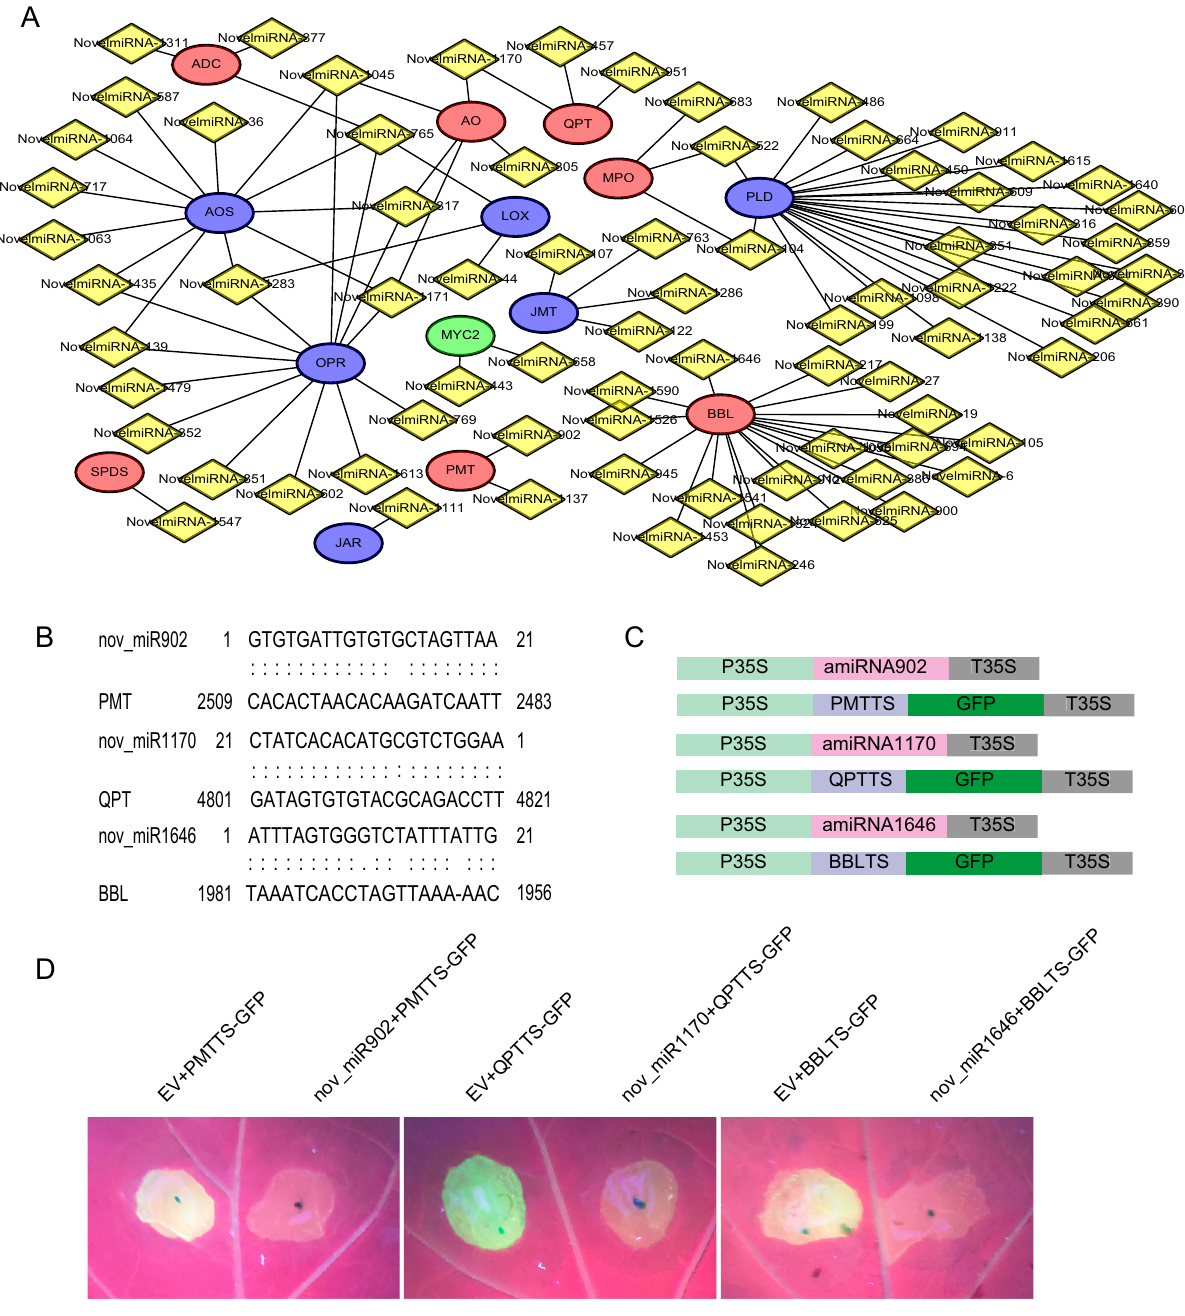
Figure 4. The miRNA-mRNA coexpression network for known nicotine biosynthesis genes. ( A ) The coexpression network for known nicotine biosynthesis genes. ( B ) Target site sequence between miRNA and their corresponding targets. ( C ) Overexpression vectors constructed for transient expression system in tobacco. ( D ) Co-infiltrated leaves were photographed at the third day after infiltration under UV light. Yellow color represents miRNA candidates; Red color represents known genes involved in nicotine biosynthesis pathway; Green color represents known transcription factors regulating nicotine biosynthesis; Blue color represents known genes involved in JA